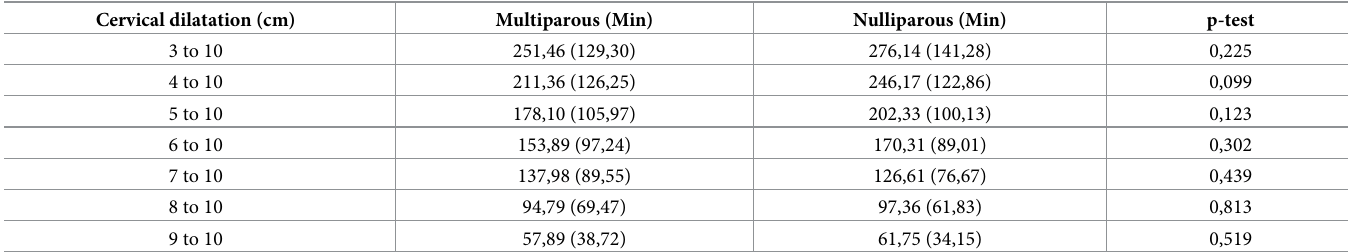
Table 4. Time (min) required from one cervical dilatation stage to the full dilatation. Results are expressed as mean and standard deviation. Cervical dilatation (cm)